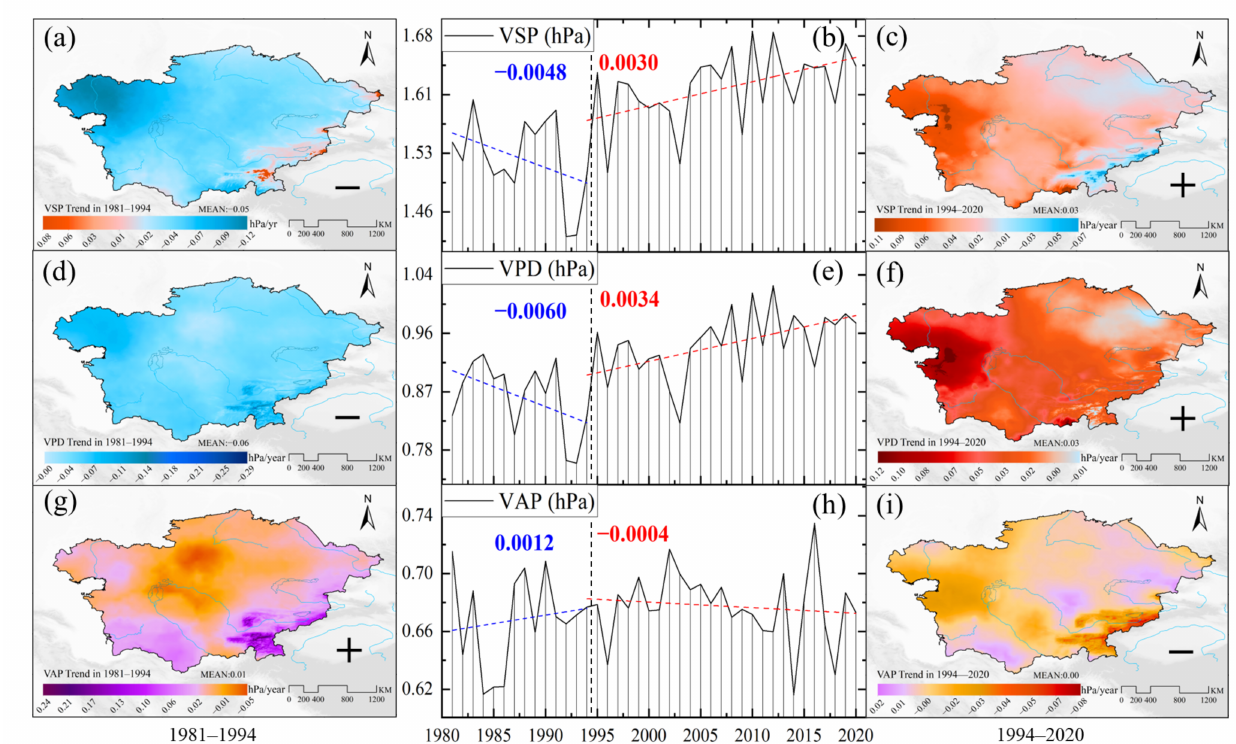
Figure 5. Temporal and spatial variation trends for VSP, VPD, and VAP. For 1981–1994: ( a ) VSP, ( d ) VPD, and ( g ) VAP; for 1994–2020: ( c ) VSP, ( f ) VPD, and ( i ) VAP; for 1981–2020: Segmentation time trends in ( b ) VSP, ( e ) VPD, and ( h ) VAP before and after 1994,